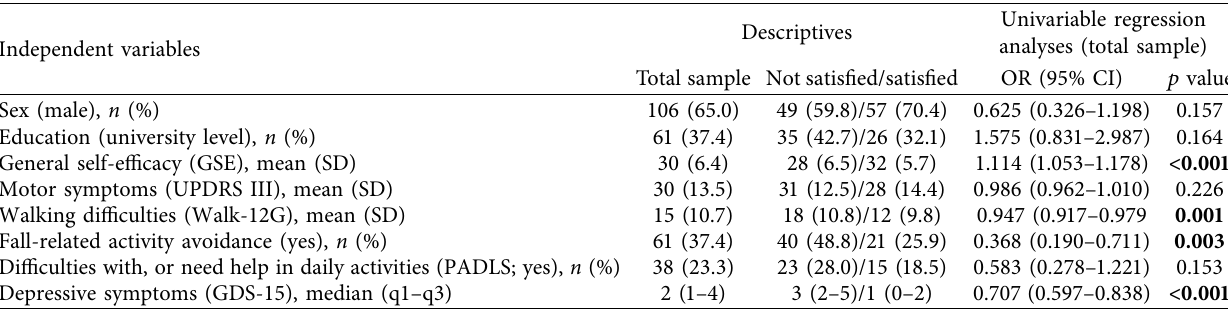
Table 1: Participants’ characteristics at baseline for the total sample and separate for those not satisfied vs. satisfied with their lives at the 3- year follow-up and univariable logistic regression analyses with life satisfaction (3-year follow-up) as the dependent variable, N � 163 1